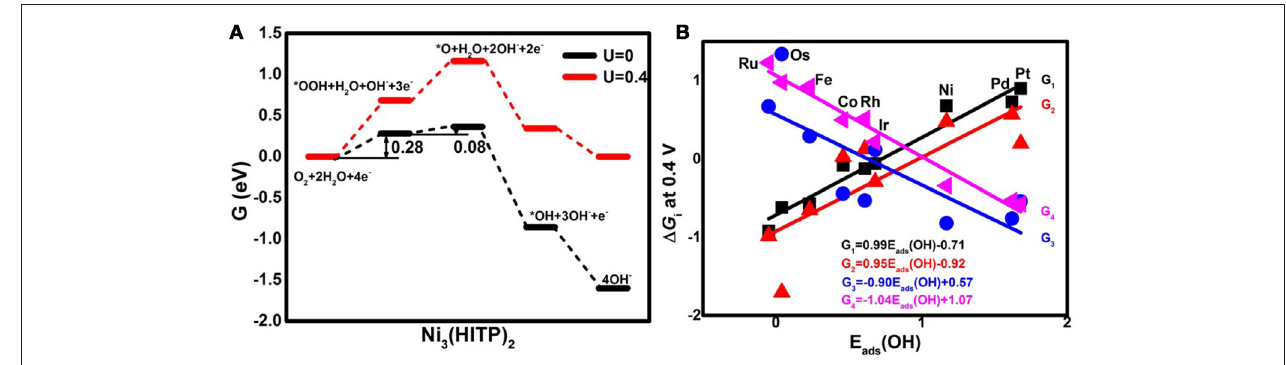
FIGURE 4 | The free energy G diagrams of Ni 3 (HITP) 2 in the alkaline medium (A) and the free energy change 1 G i of the elemental step R i at the ideal potential of 0.4eV (B) .